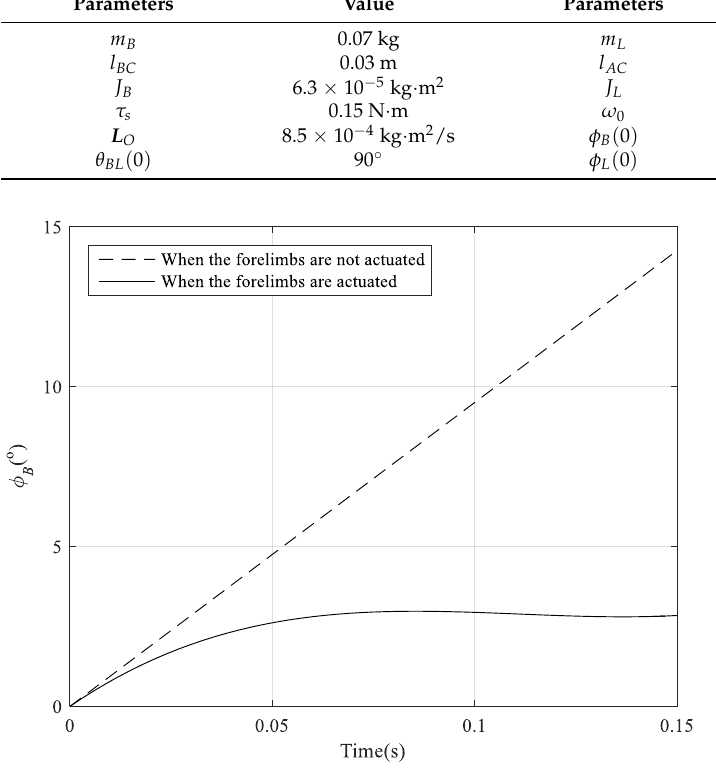
Figure 20. Simulation results for pitching adjustment under different states of forelimbs.